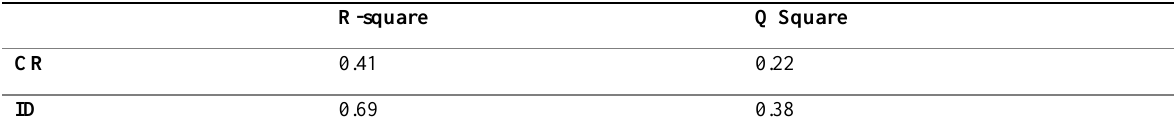
Table 5: R 2 and Cross-validate Redundancy